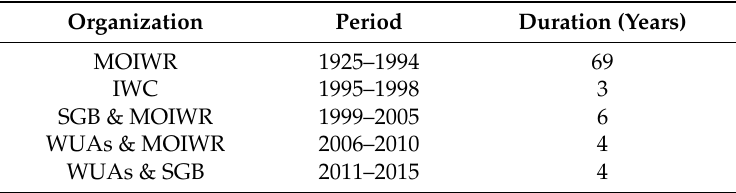
Table 1. The main organizations responsible for irrigation